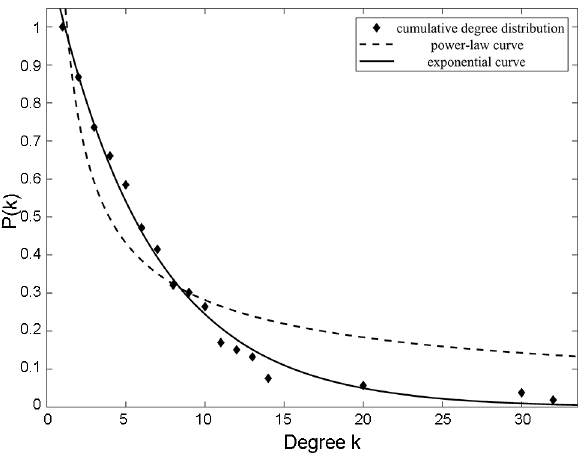
Figure 7. Comparison between power-law curve and exponential curve